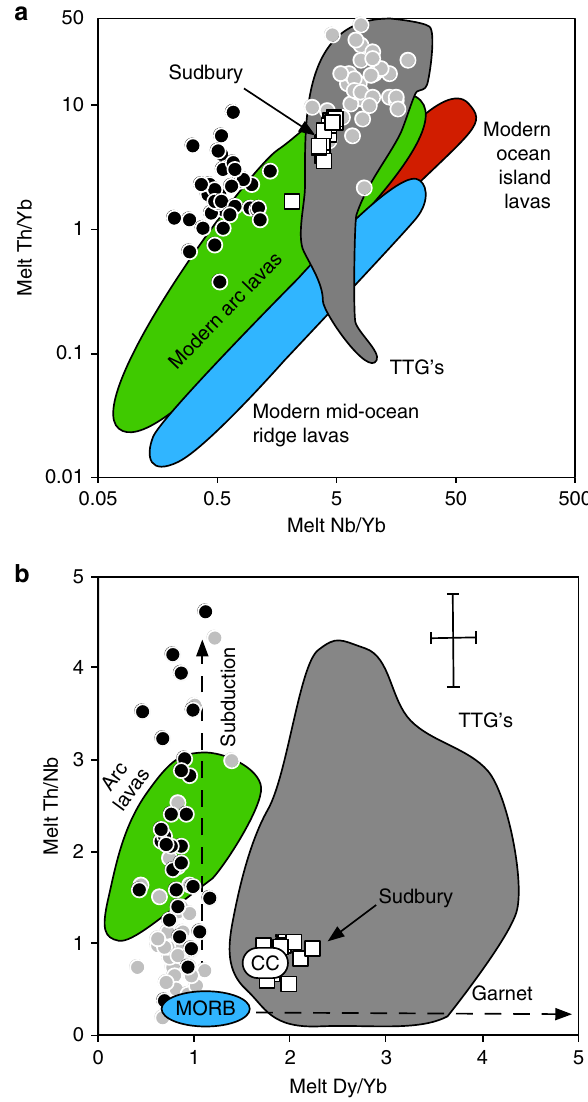
Fig. 2 Tectonic af fi nity of the Jack Hills zircon protoliths. a Trace element discrimination diagram 25 showing comparison of melts in equilibrium with Jack Hills zircons with the fi elds for modern arc rocks, mid-ocean ridge and ocean island basalts. b Plot of Th/Nb versus Dy/Yb for melts in equilibrium with the Jack Hills zircons along with vectors indicating the contrasting effects of subduction and melting (or crystallisation) in the presence of garnet. Black circles assume experimental zircon/melt partition coef fi cients 22 . For comparison, the grey circles assume empirical zircon/ melt partition coef fi cients 28 . Also shown are the composition of Sudbury rocks (white squares) inferred to have formed from impact-induced melting 44 and the TTG fi eld for trondhjemite-tonalite-granodiorite suites (data compilation from GEOROC). Average crustal composition 24 (CC) and MORB 43 are also shown. Error bars in b are 1 σ (see Methods